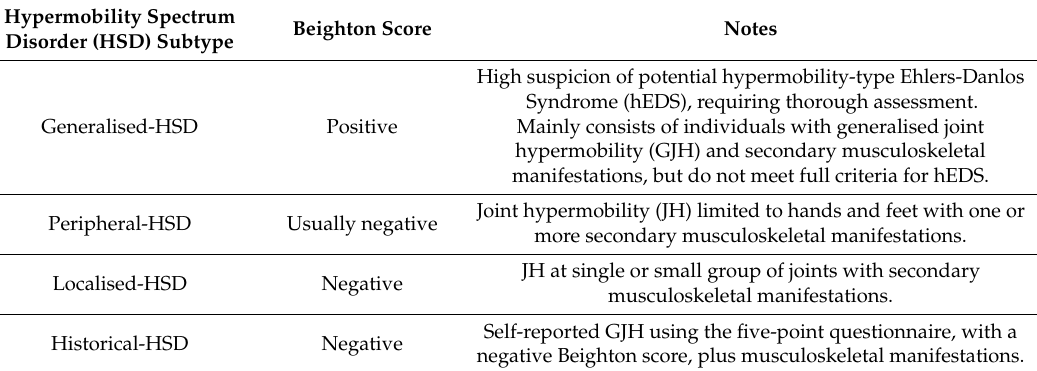
Table 4. Summary of hypermobility spectrum disorder subtypes. Adapted from Castori et al., 2017 [15].